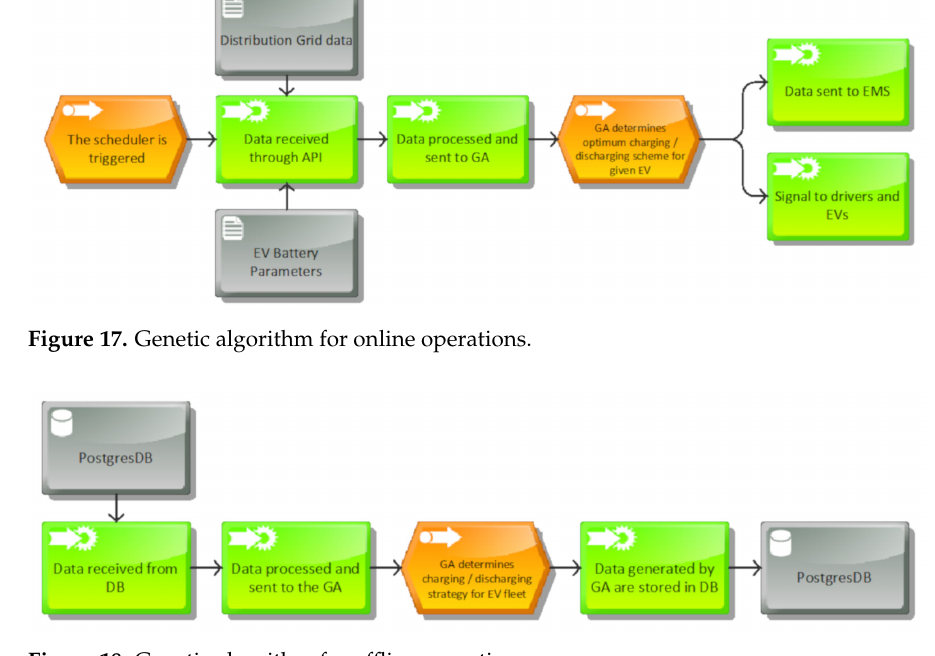
Figure 18. Genetic algorithm for offline